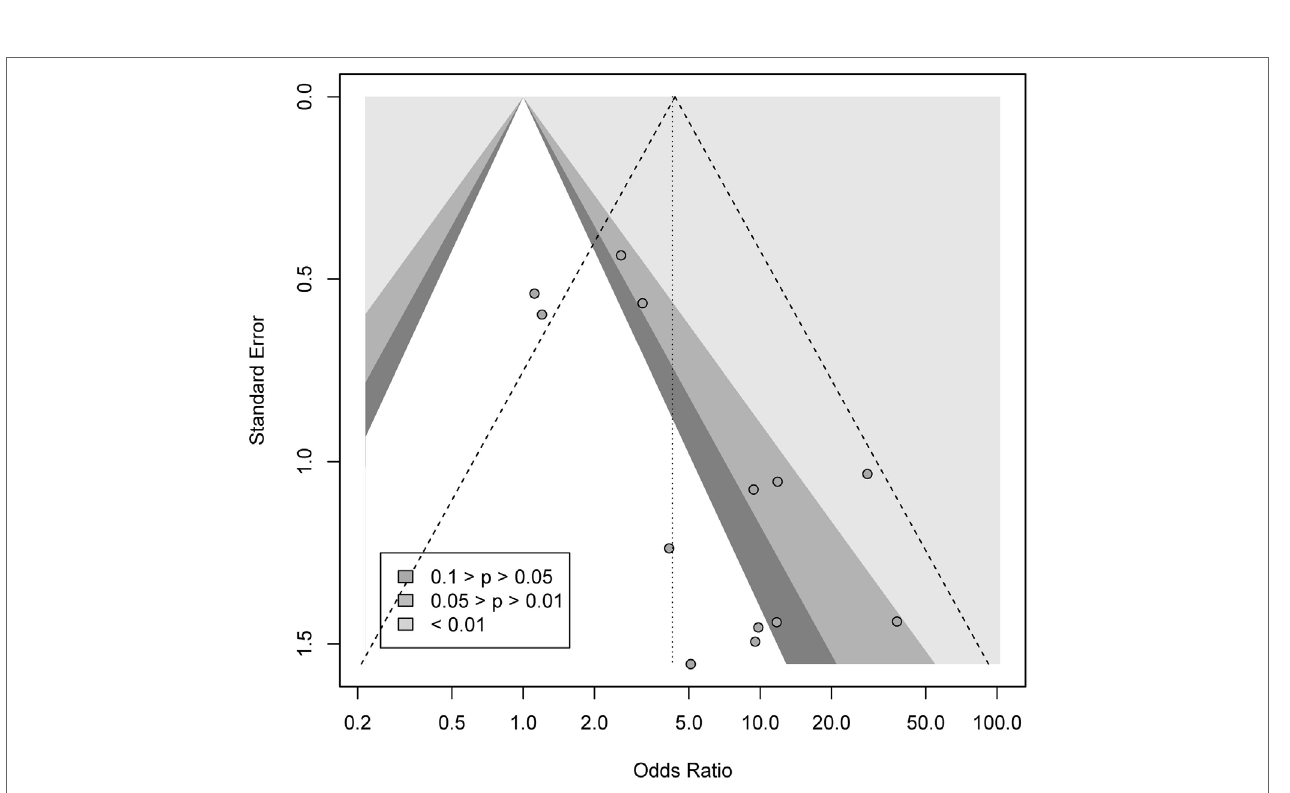
FigURe 7 | Contour-enhanced funnel plot for hypersexuality.